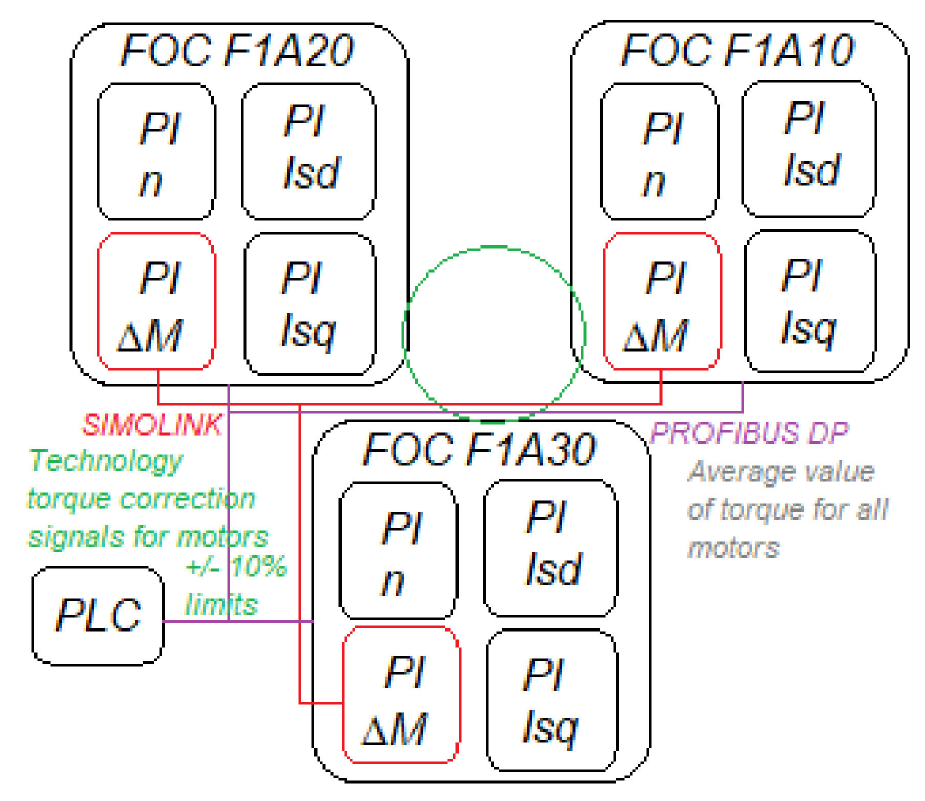
Figure 11. Communication model after torque